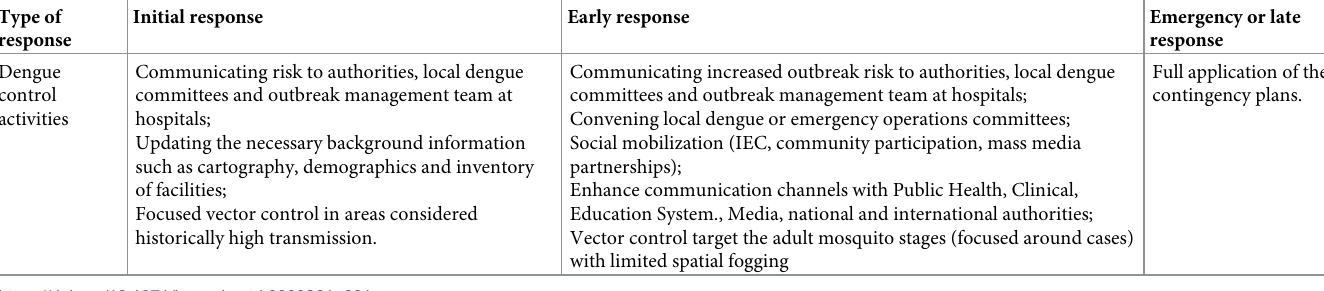
Table 1. Type of response and the corresponding dengue control